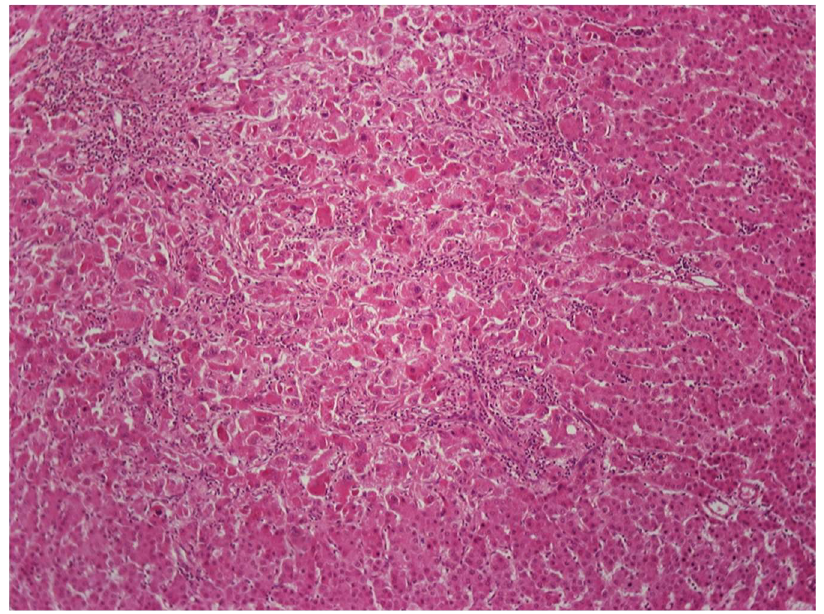
Figure 4. Classic HCC arising within early HCC (right and lower parts of the picture). Note the small unpaired arteries (right middle and lower part of the picture).